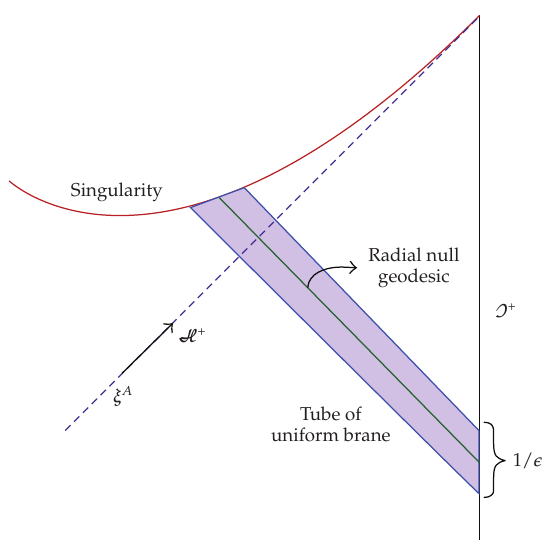
Figure 4: The causal structure of the spacetimes dual to fluid mechanics illustrating the tube structure. The dashed line denotes the future event horizon H (cid:9) generated by ξ A , while the shaded tube indicates the region of spacetime over which the solution is well approximated by a tube of the uniform black